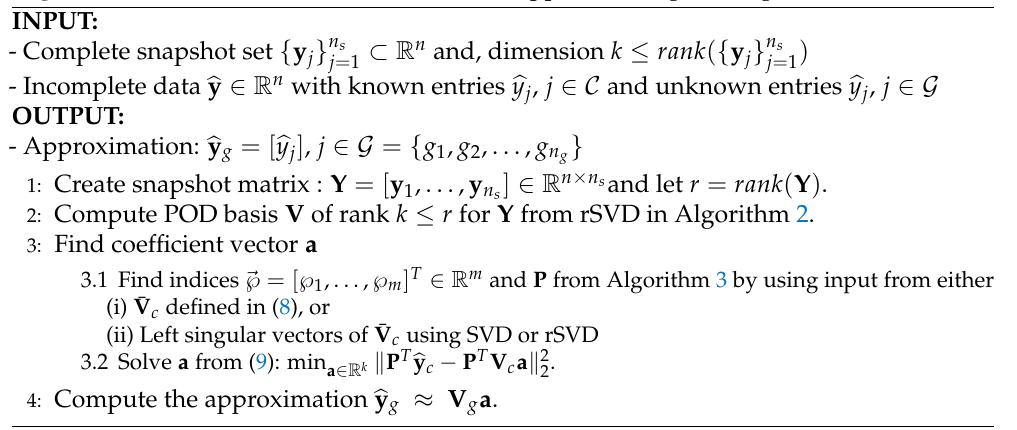
Algorithm 4 Accelerated POD-LS method for approximating missing